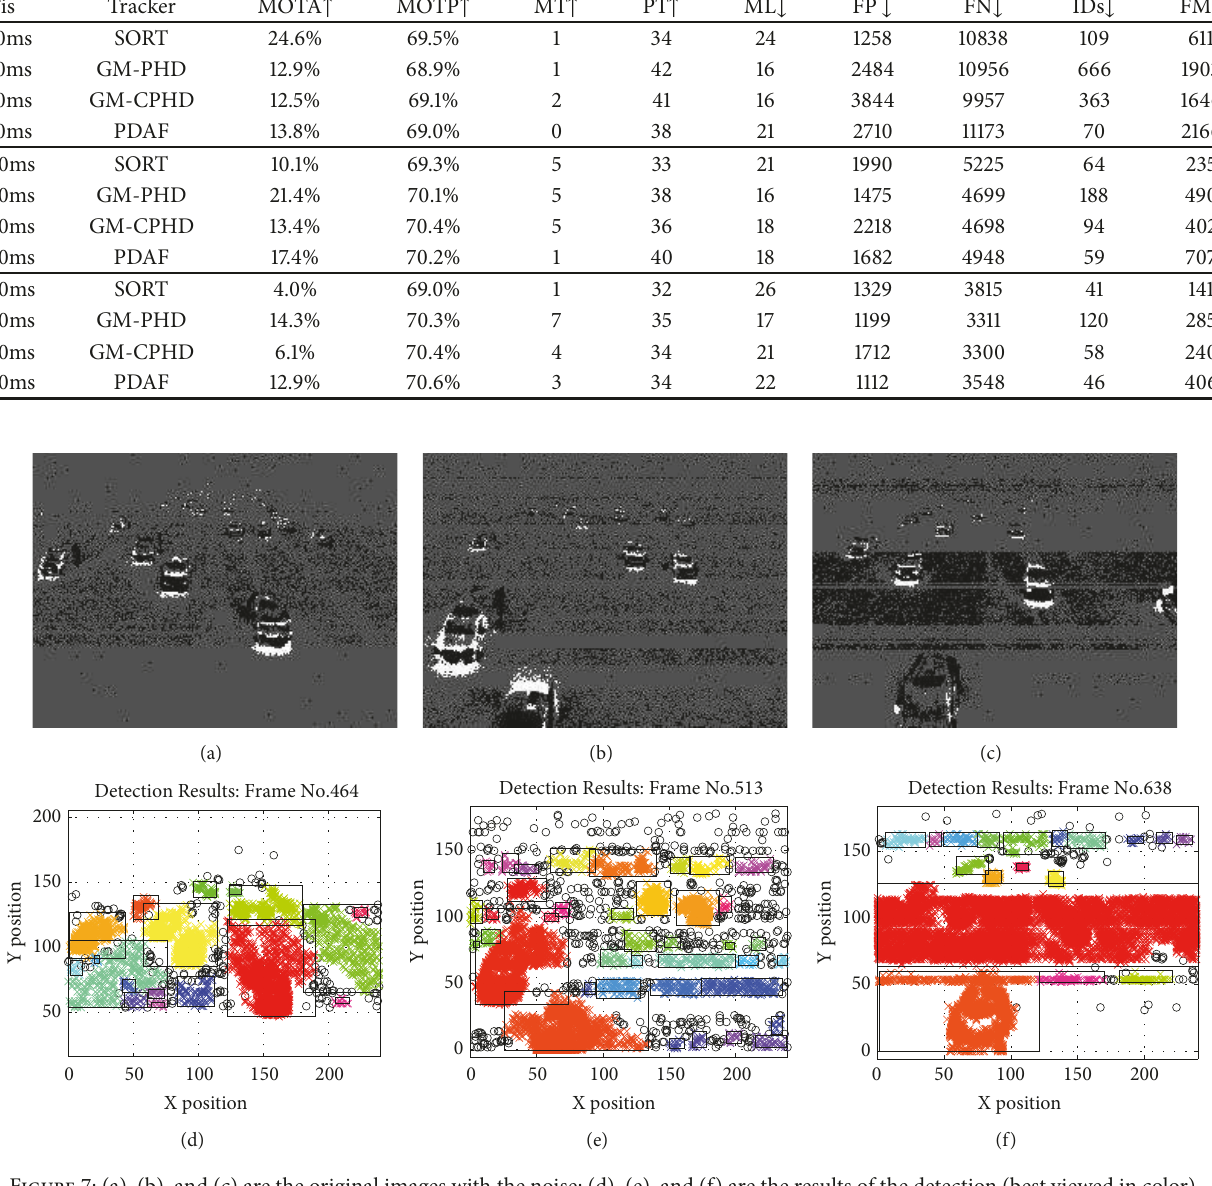
Figure 7: (a), (b), and (c) are the original images with the noise; (d), (e), and (f) are the results of the detection (best viewed in